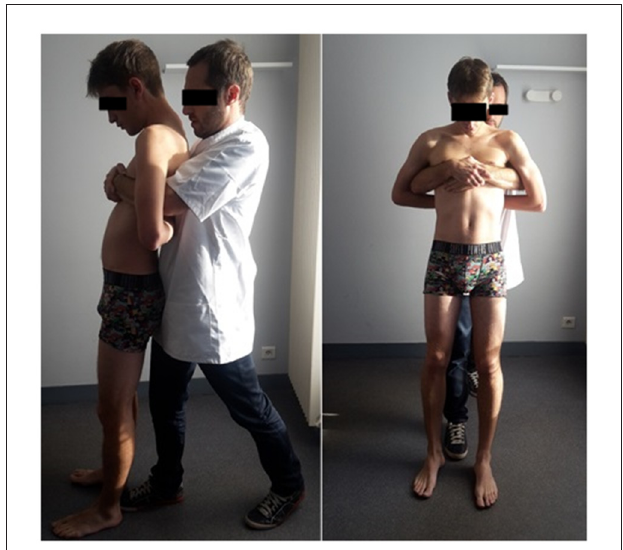
FIGURE 2 | Profile (left) and front (right) views of the participant’s and the practitioner’s initial postures in the sham and HVLA manipulations. The written informed consent was obtained from the participants depicted in the images.